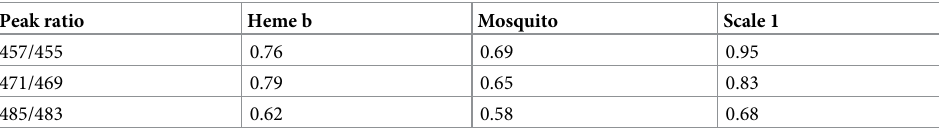
Table 1. Ratios of porphyrin